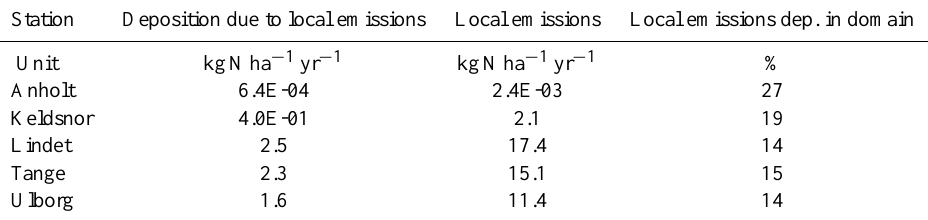
Table 4. The modelled annual NH 3 deposition within the OML-DEP domain related to the local emissions alone. Given as both kgNha − 1 yr − 1 and as% of the NH 3 emitted from local